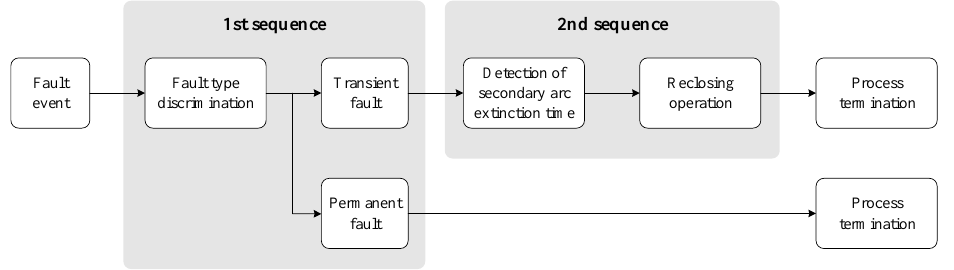
Figure 7. Total operation concept of the proposed ASPAR scheme.